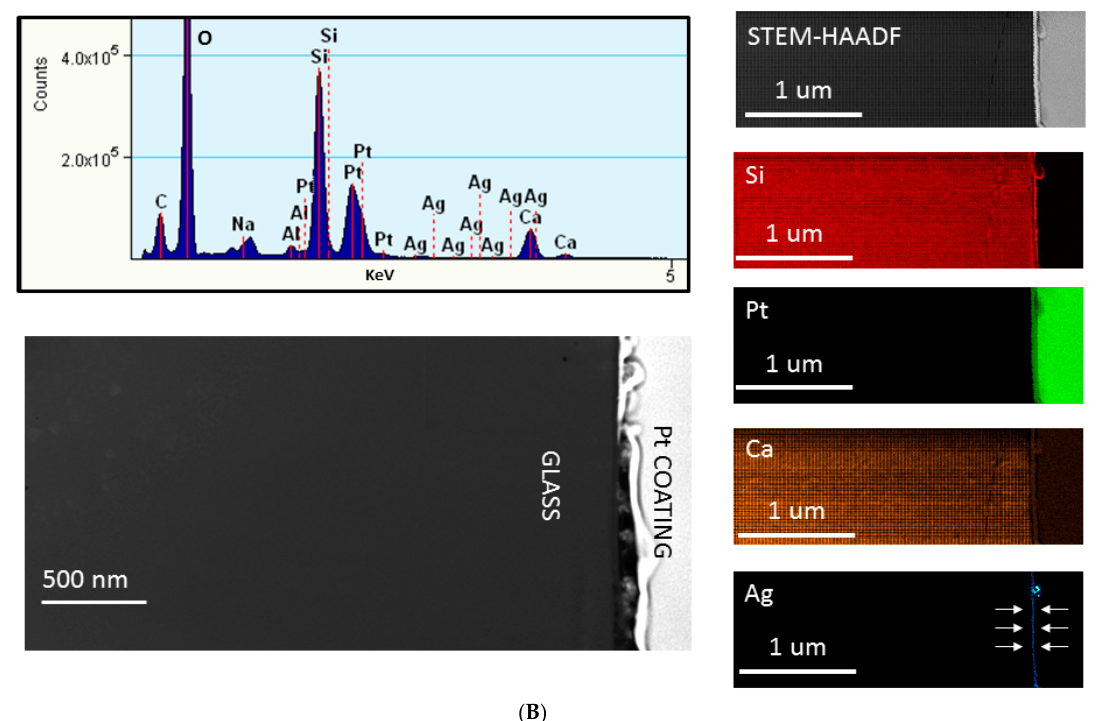
Figure 2. TEM-EDS data and images obtained on the cross-sections of Ti64(Sr+Ag) ( A ) and SBA2-Ag ( B ).